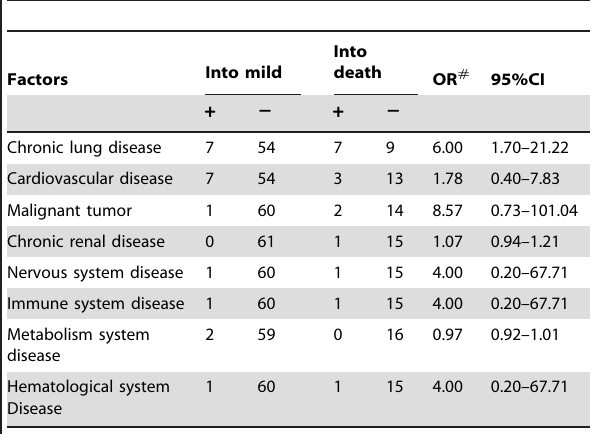
Table 2. Univariate analysis of potential risk factors associated with the death of pH1N1 influenza severe cases in the first epidemic